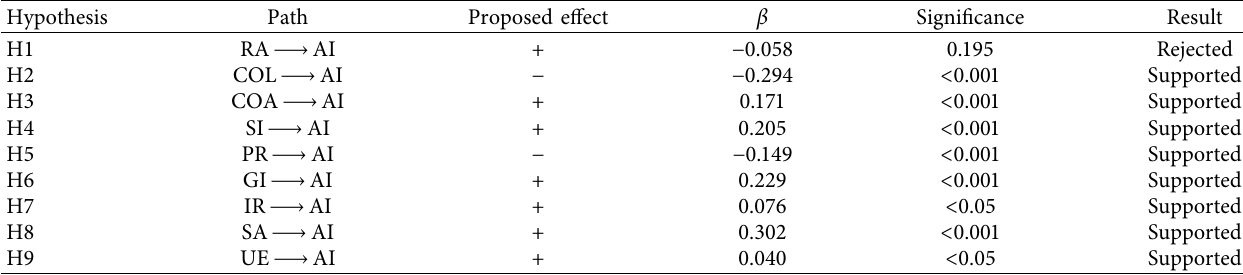
Table 8: Results of path analysis.